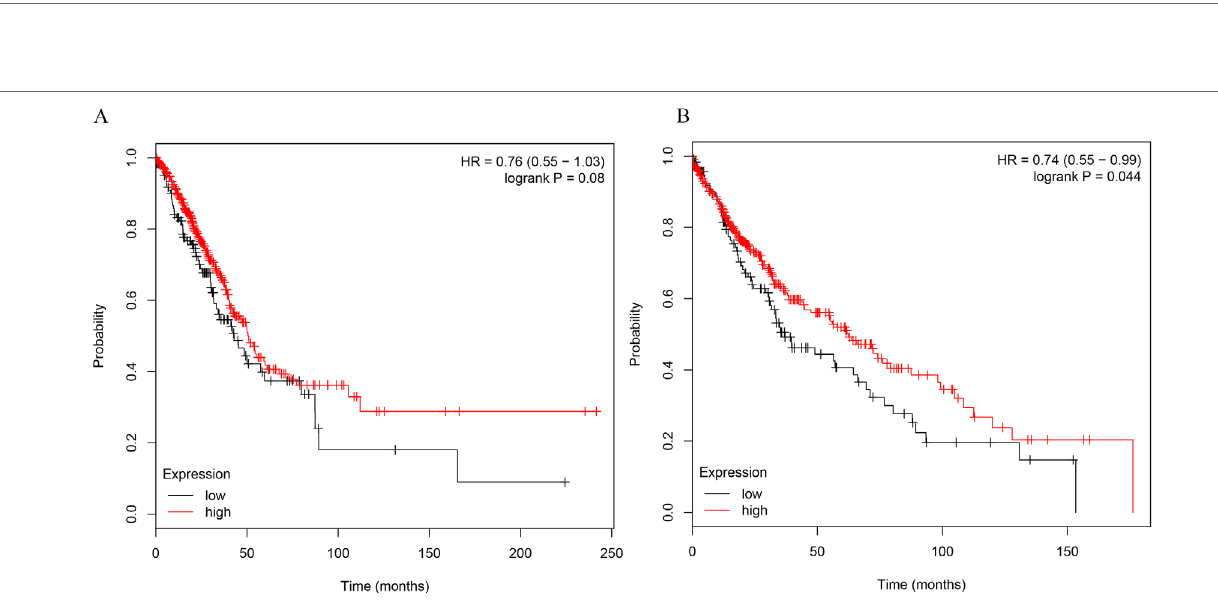
FIGURE 2 | The correlations of miR-486-5p levels and survival months in NSCLC patients. (A) No significant correlation between miR-486-5p expression and prognosis data in AC patients (504 samples, p = 0.08). (B) SCC patients with low expression of miR-486-5p had worse prognosis (472 samples, p =